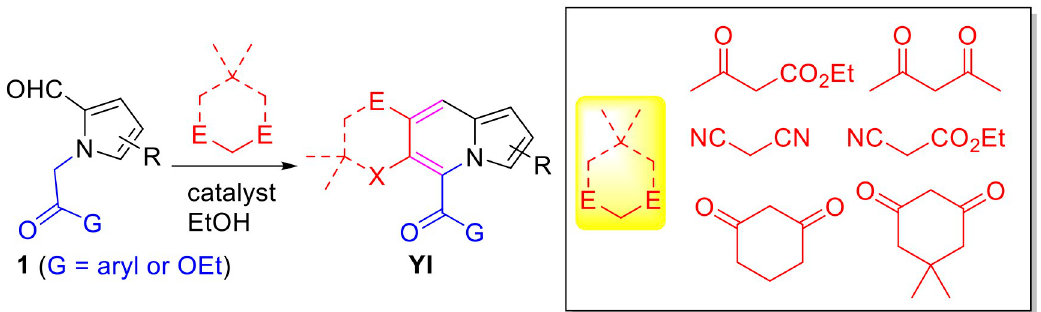
Fig 6. A scheme of synthesizing new indolizines.